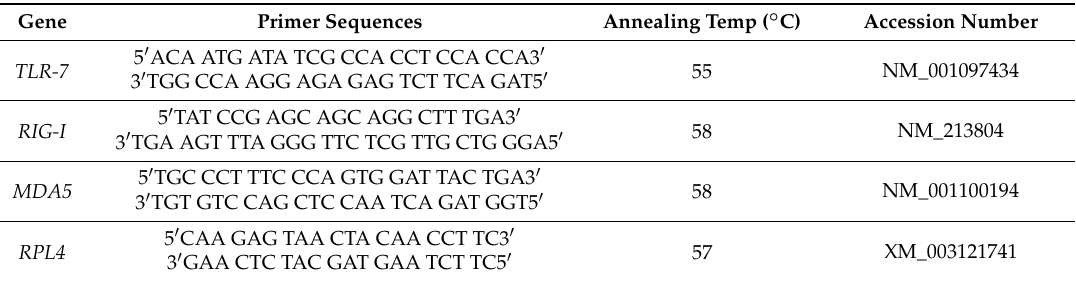
Table 3. qPCR primers for the quantification of